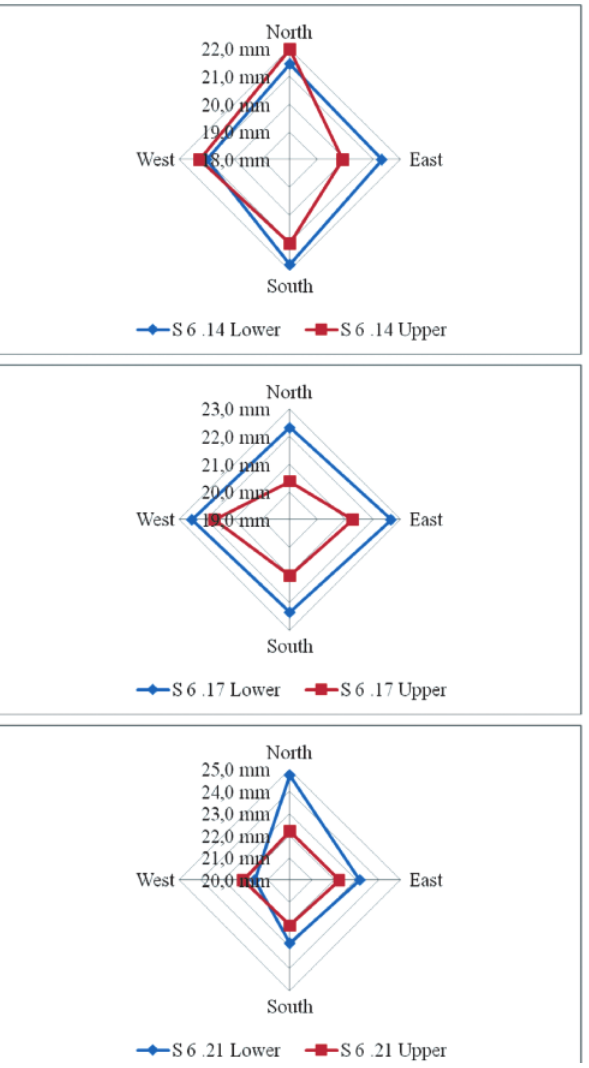
Fig. 5: The width in the function of time, orientation and height in the case of Stella [mm]